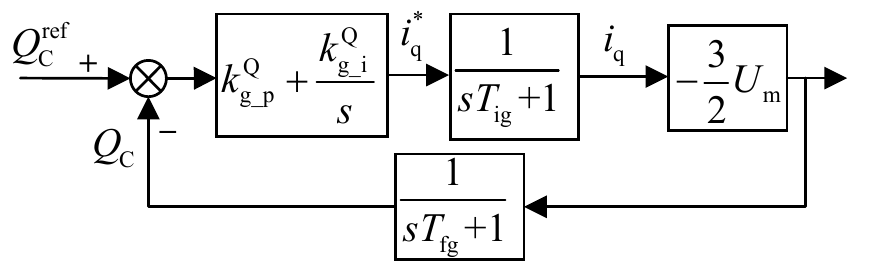
7 of 19 Figure 7. The GSC control block diagram. GSC reactive power in the grid-voltage-oriented synchronously rotating reference frame can be modeled as,